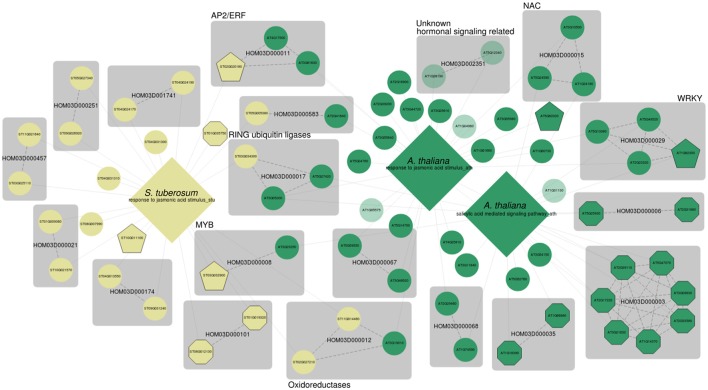
MorphDB network for GO:0009753 (response to jasmonic acid stimulus) and GO:0009863 (SA mediated signaling pathway) for A. thaliana (green) and S. tuberosum (pale yellow). Only the top 50 candidates for each GO category that have a homolog predicted in some other species in MorphDB are shown. For more details, see Figure 2.